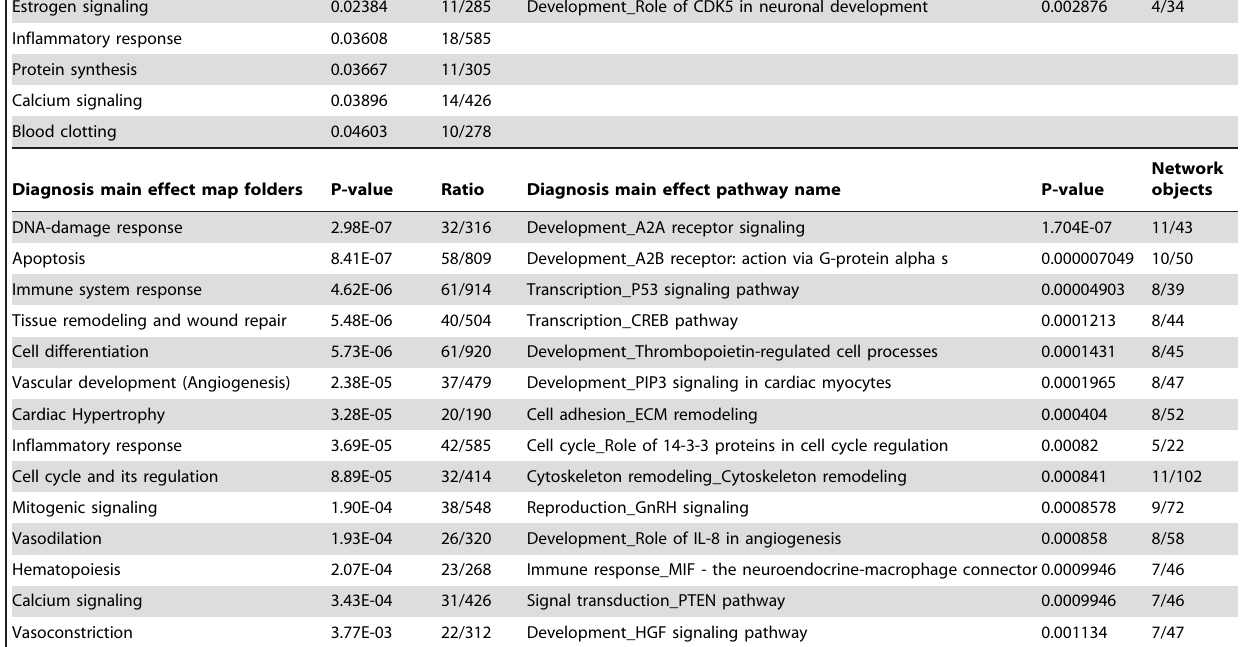
Young autism versus young control map